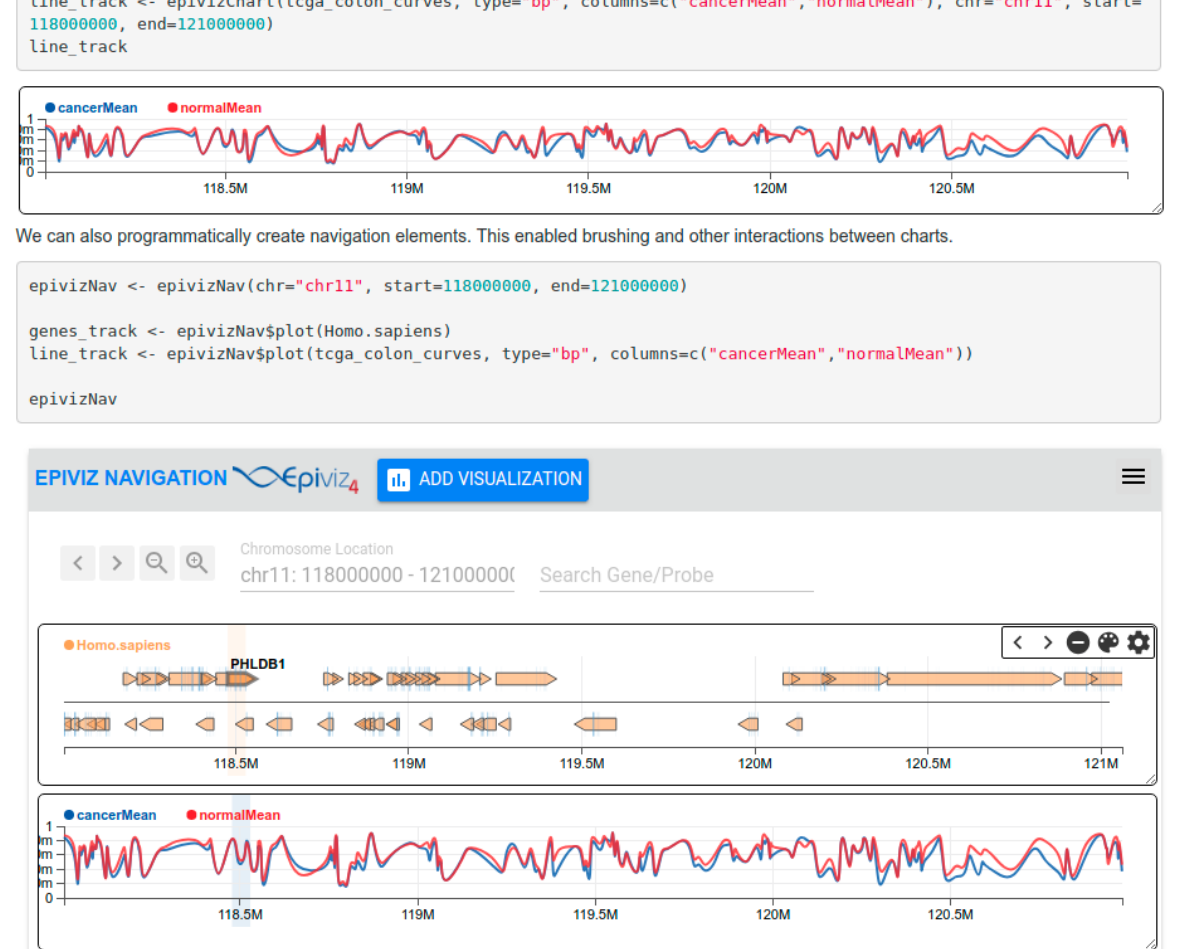
Figure 4. Interactive visualization of R/Bioconductor data objects using the epivizrChart package. This figure is part of an RMarkdown document and demonstrates the ease of integrating the visualizations from the Epiviz component library with existing frameworks. The epivizChart function infers the chart type based on the data object parameter. “Homo.sapiens” from the top panel is a UCSC Gene annotation object for human hg19 reference genome and is visualized by epivizChart as a genes track. t cga_colon_curves is a sample dataset from The Cancer Genome Atlas for colon tissue. This is a GRanges object and is visualized as a Line Track. The epivizrChart package can also programmatically create navigation elements. This enables interactions and brushing across the charts as shown in the bottom panel around the gene “PHLDB1”. A vignette describing more examples and use cases is available in the package either on the GitHub repository or through Bioconductor